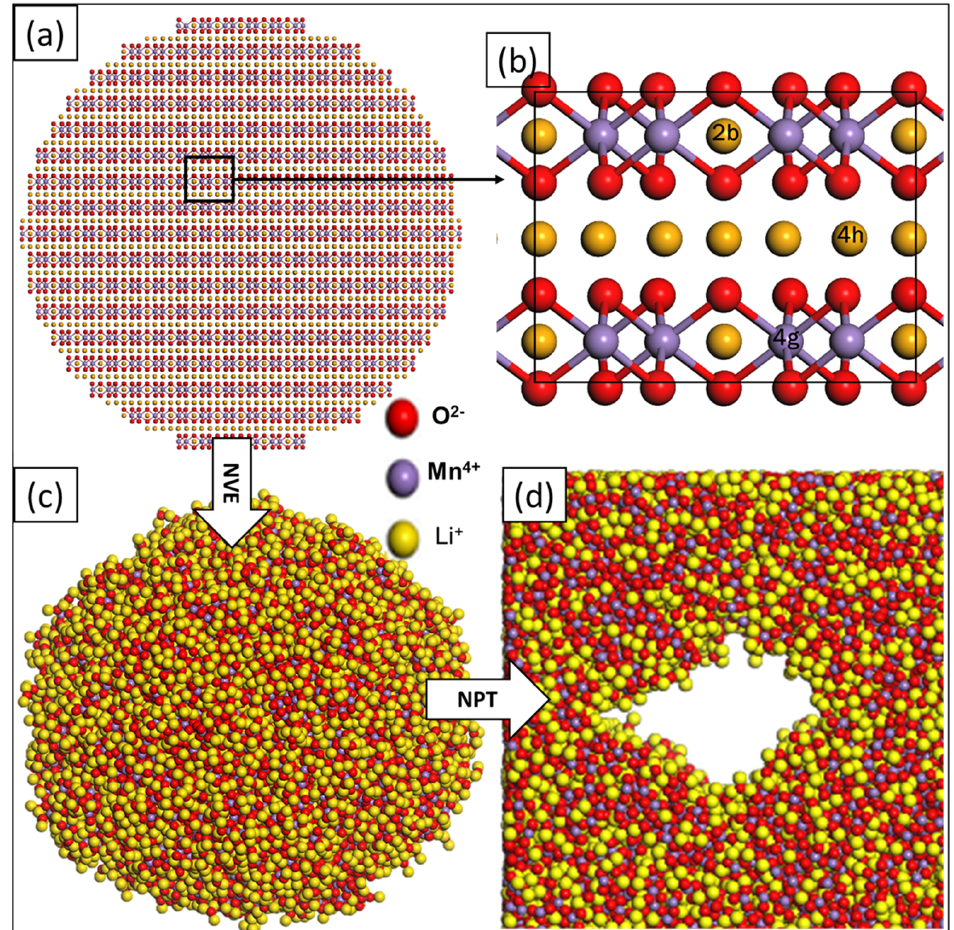
Figure 1. Schematic diagrams representing ( a ) the spherical layered Li 2 MnO 3 , ( b ) magnified portion of ( a ) revealing the atomic arrangement of Li, Mn, and O, ( c ) amorphous nanosphere Li 2 MnO 3 , and ( d ) amorphous nanoporous Li 2 MnO 3 configurations.